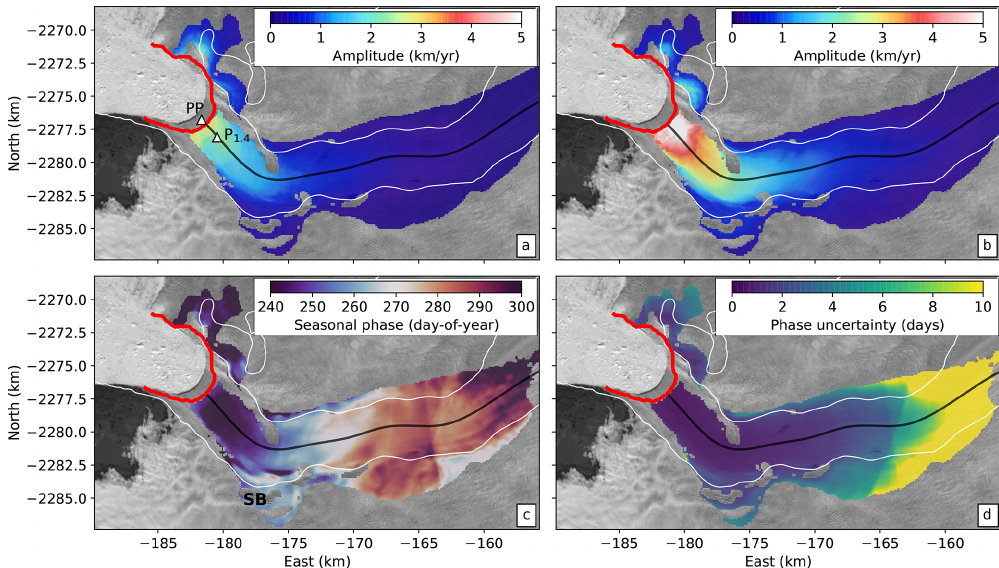
Figure 4. Seasonal variations in flow speed and timing of peak velocities. (a) Mean seasonal velocity amplitude for the years 2009–2011 and 2017–2018 (years not associated with the increased velocities between 2012 and 2015). Triangular markers indicate comparison points used in Fig. 7: pinning point (PP) where the bed topography locally narrows and reference point 1.4km upstream from the 2017 front position ( P 1 . 4 ). (b) Mean seasonal velocity magnitude variation for the years 2012–2015 (2016 excluded due to higher background velocities at the start of the summer). (c) Mean day of year of peak seasonal velocity (i.e., seasonal phase) for entire observation period. SB indicates the southern bend referred to in the text. (d) Seasonal phase uncertainty (1 σ ). Seasonal amplitudes are measured as the difference between the summer high and winter low velocities in the short-term time series as shown in Fig. 1c. The highest amplitudes occur at the terminus and decay exponentially